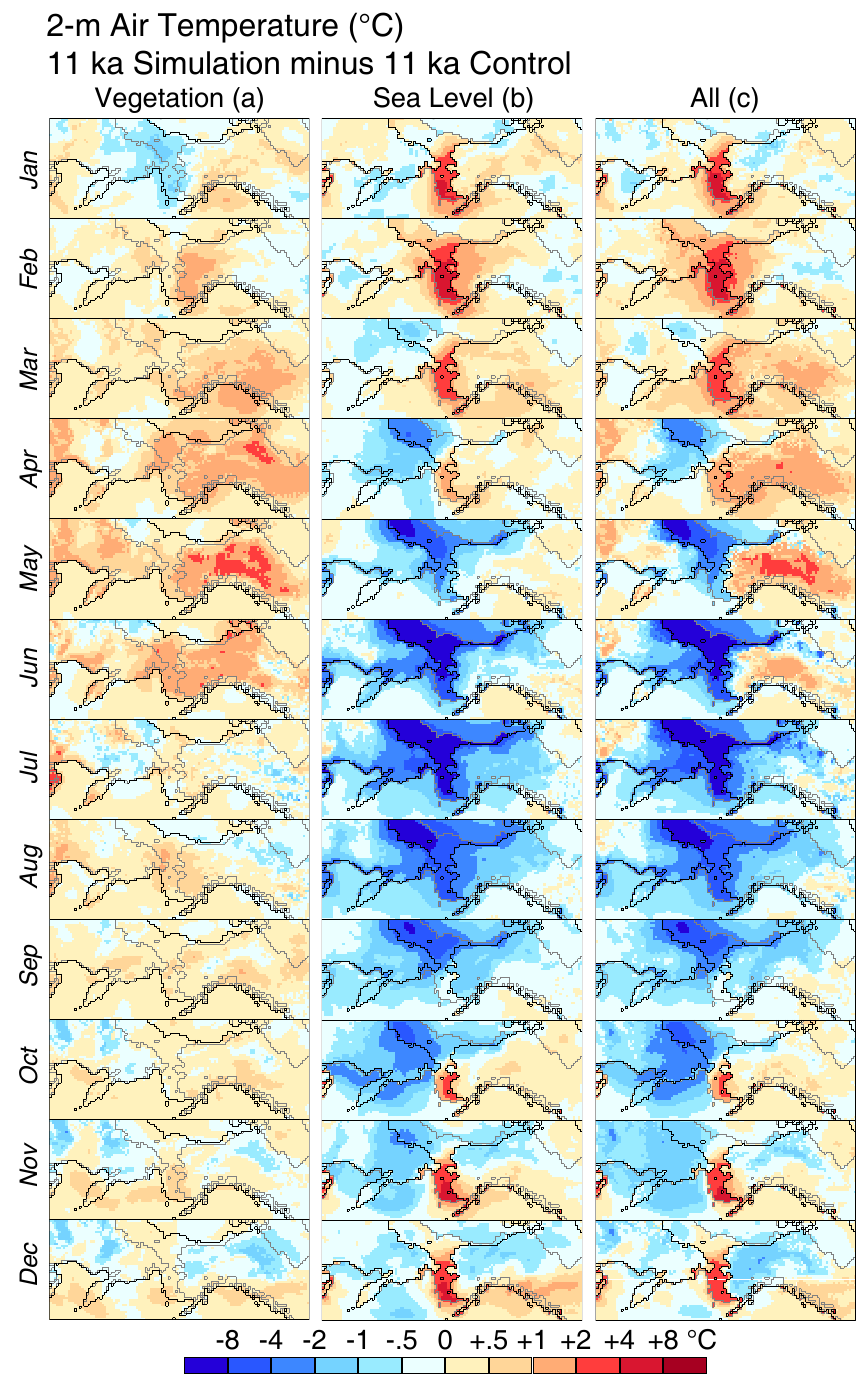
Figure 9. The effect on 2m air temperature ( ◦ C) of changing vegetation (a) , sea level (b) and all three land cover changes (vegetation, sea level and lakes; c ) at 11ka. Ice-sheet and coastal outlines as in Fig. 4.